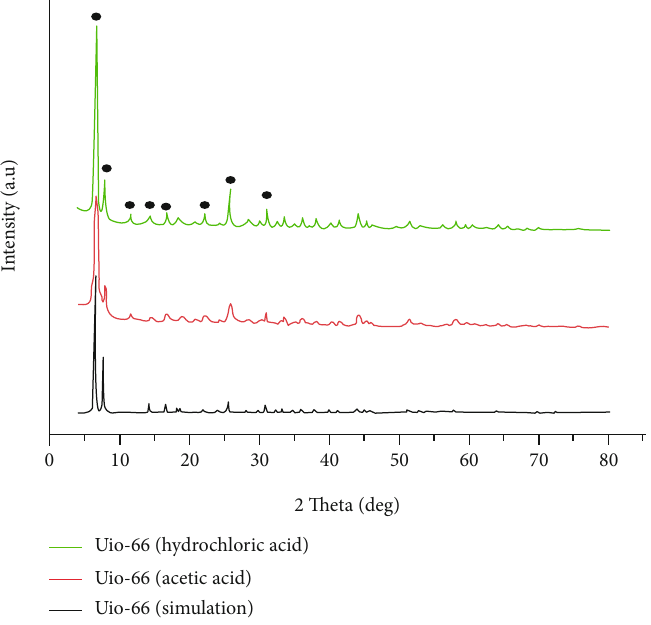
Figure 1: XRD spectra (-UiO-66 (hydrochloric acid); -UiO-66 (acetic acid); -UiO-66